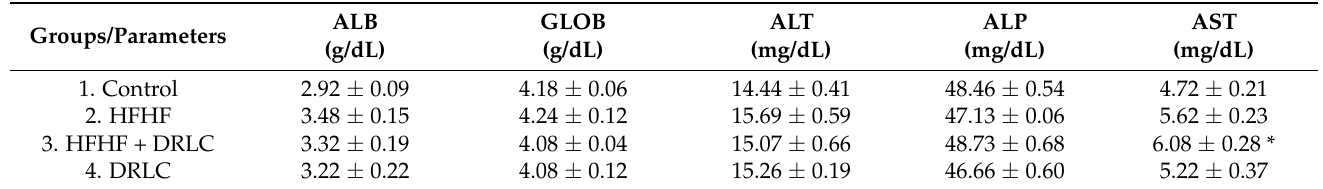
Table 2. Effects of D-ribose-L-cysteine (DRLC) on hepatic enzymes and proteins in male Wistar rats fed with high fructose-high fat (HFHF) diet.